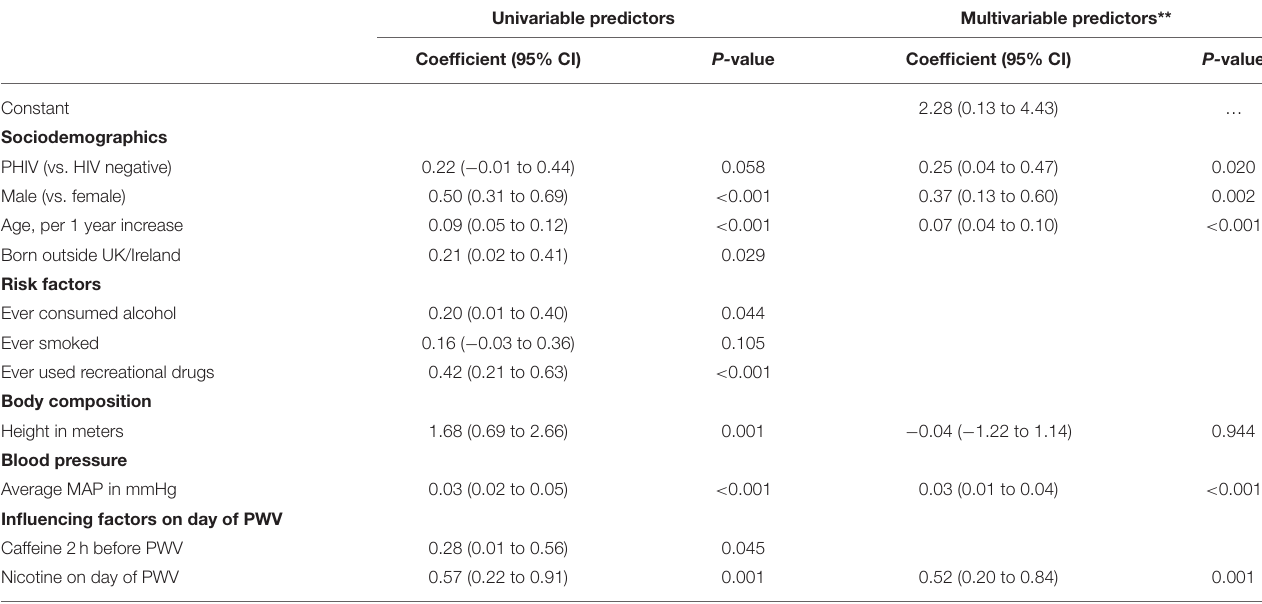
TABLE 3 | Univariable and multivariable predictors of PWV in PHIV and HIV negative young people.